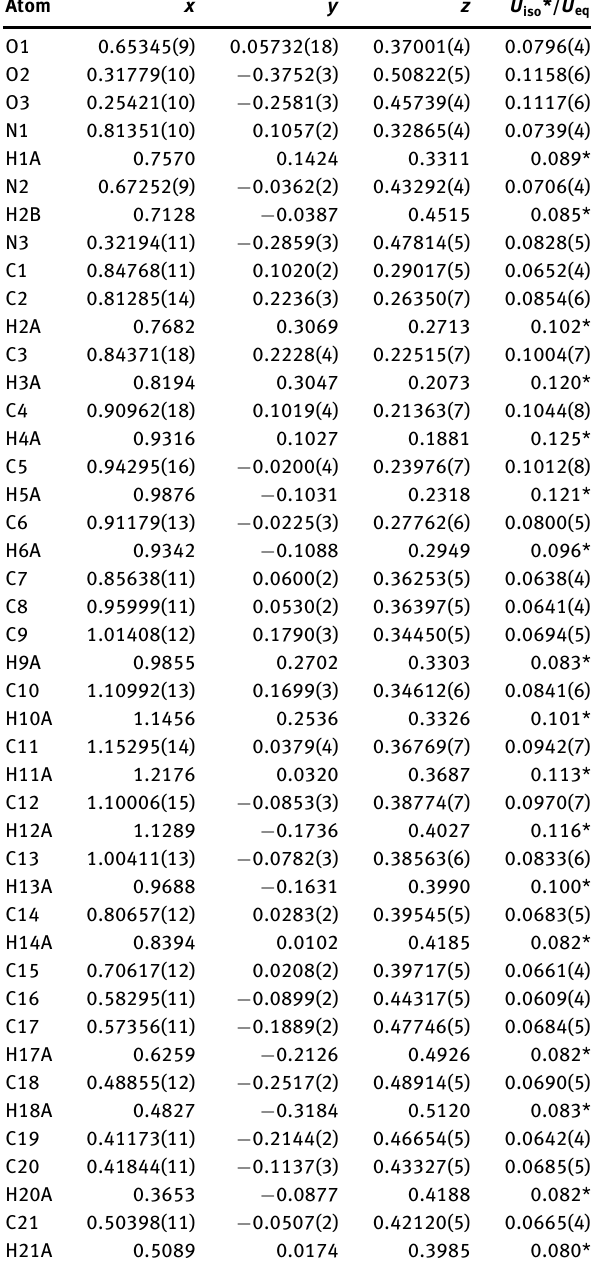
Table 2: Fractional atomic coordinates and isotropic or equivalent isotropic displacement parameters (Å 2